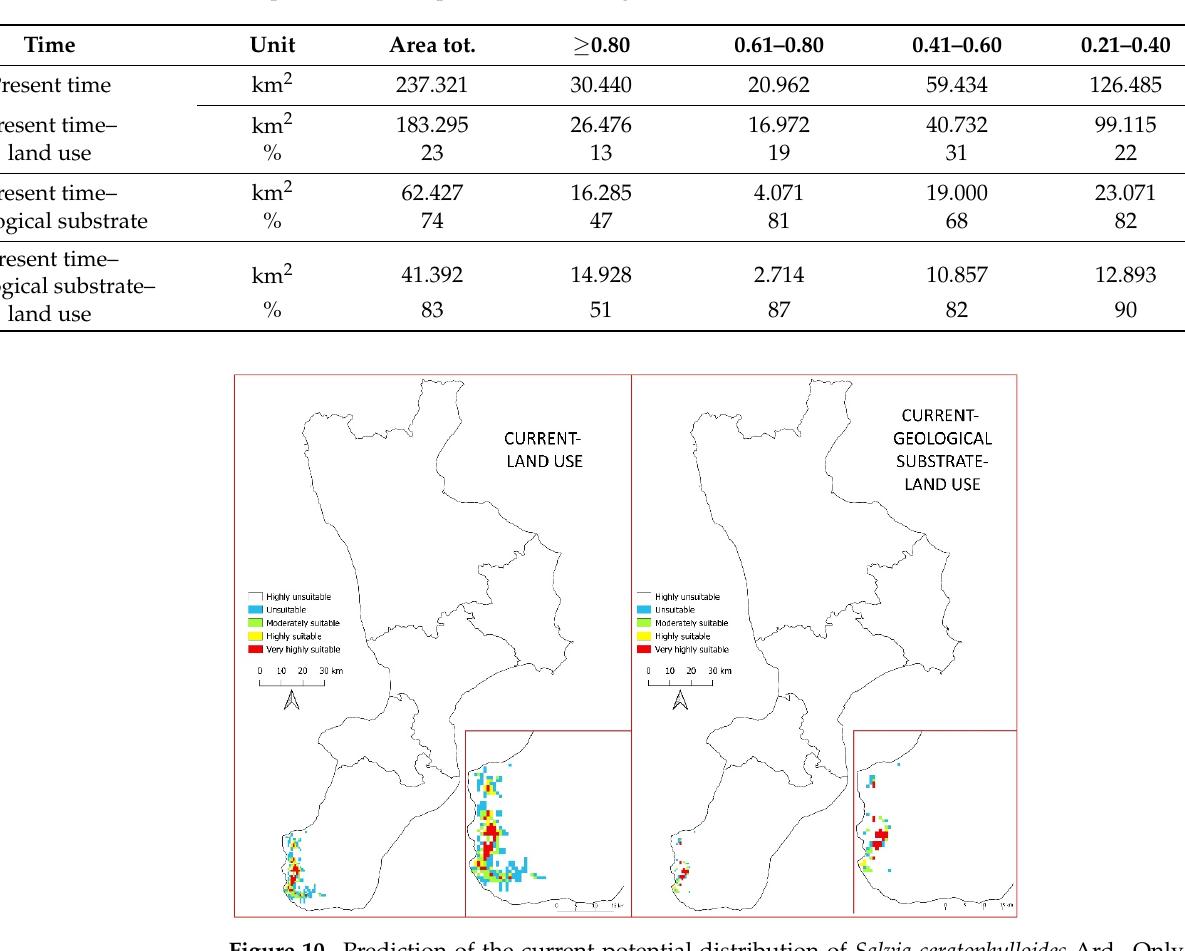
Figure 10. Prediction of the current potential distribution of Salvia ceratophylloides Ard. Only in relation to land use and land use with geological substrate. In white, highly unsuitable ( ≤ 0.20); in blue, unsuitable (0.21–0.40); in green, moderately suitable (0.41–0.60); in yellow, highly suitable (0.61–0.80); and in red, very highly suitable ( ≥ 0.80).